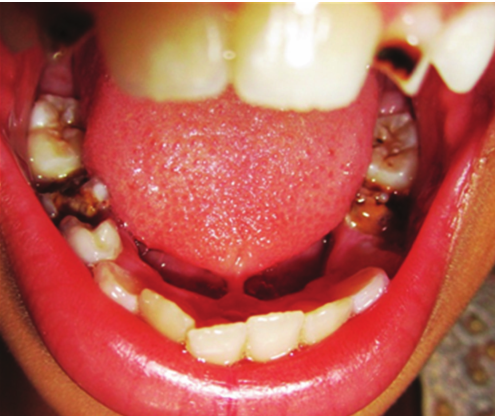
F 1: Preoperative photograph (Case 1).